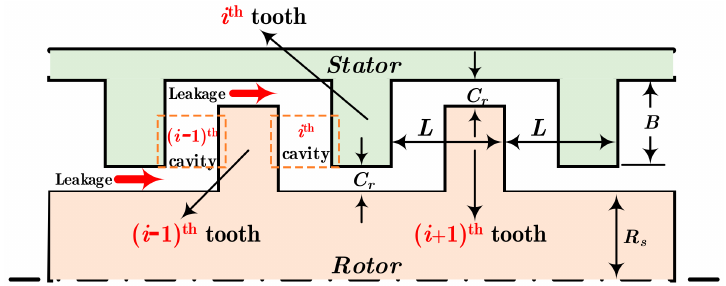
Figure 1. Geometry of an interlocking labyrinth